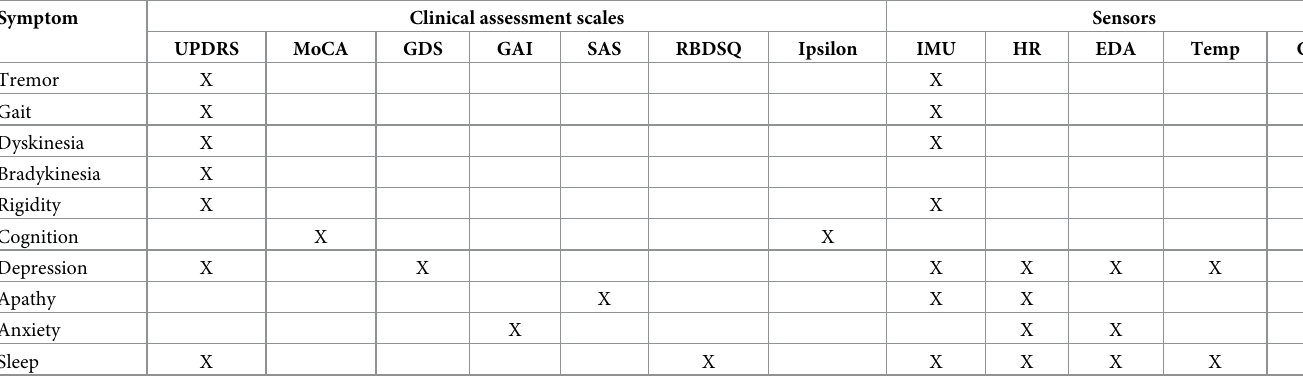
Table 1. Clinical assessment scales.